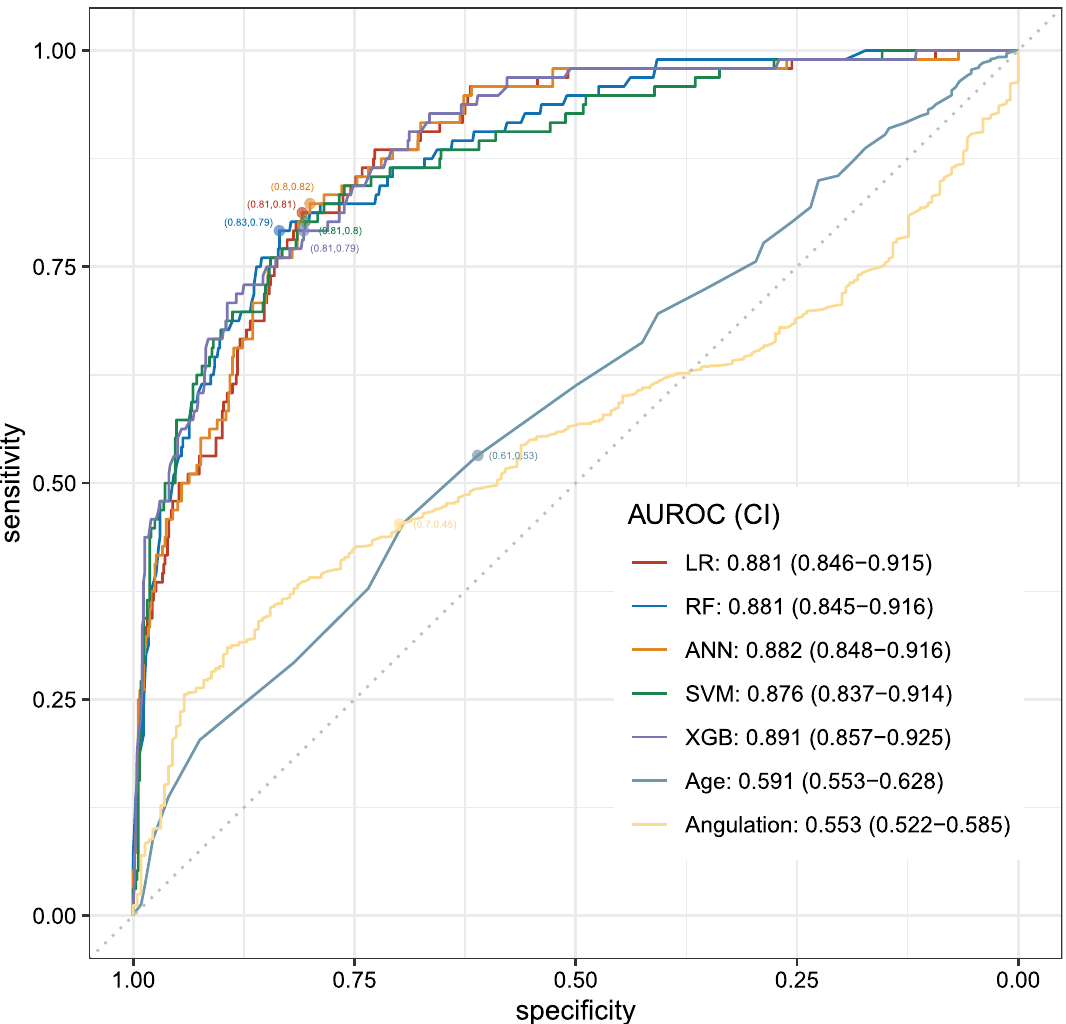
Figure 2. Receiver operating characteristic curves plotted from testing dataset. The optimal threshold is plotted as the point closest to the top-left part of the plot. AUROC area under the ROC curve, CI confidence